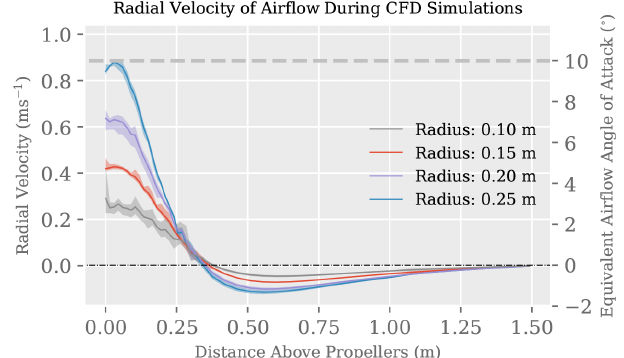
Figure 8. CFD results for the (circumferentially averaged) radial velocity of the airflow as a function of distance above the propellers. The shaded regions around the lines show the variation in the air velocity around the circumference of the domain, while the bold lines show the mean. The dashed line represents the angle-of-attack limit specified in Smith et al.